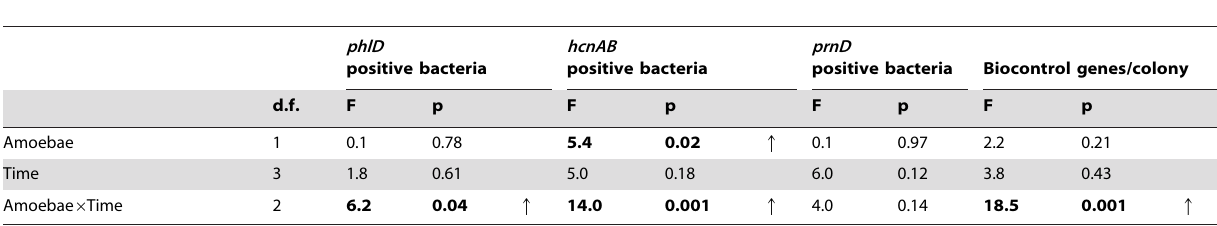
Table 1. Results of Poisson General Linear Models on the effects of Amoebae, Time and interaction between Amoebae and Time on the frequency of phlD , hcnAB and prnD positive bacteria, and on the frequency of biocontrol genes per colony in the microcosm experiment with